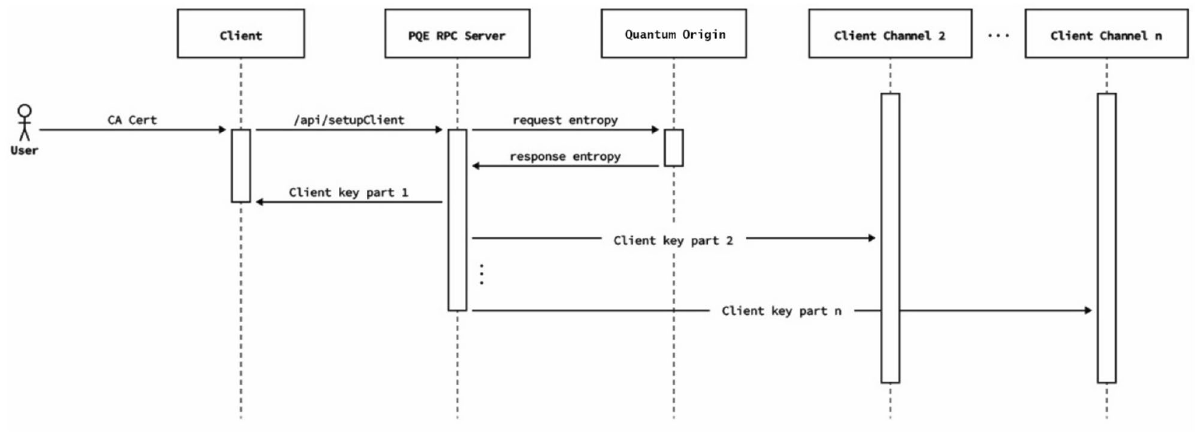
Figure 1. High-level schema of the first connection between the remote source of entropy and the blockchain